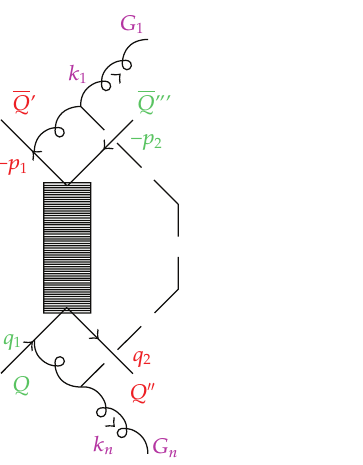
(cid:3) (cid:3)(cid:3)(cid:3) (cid:8) Figure 2: The process Q Q → Q Q (cid:3)(cid:3) (cid:8) n (cid:3) G (cid:4) . The four-momenta are indicated in the standard manner: q 1 is the four-momentum of the incoming Q , q 2 is the four-momentum of the outgoing Q (cid:3)(cid:3) , and so forth, and Q (cid:7)